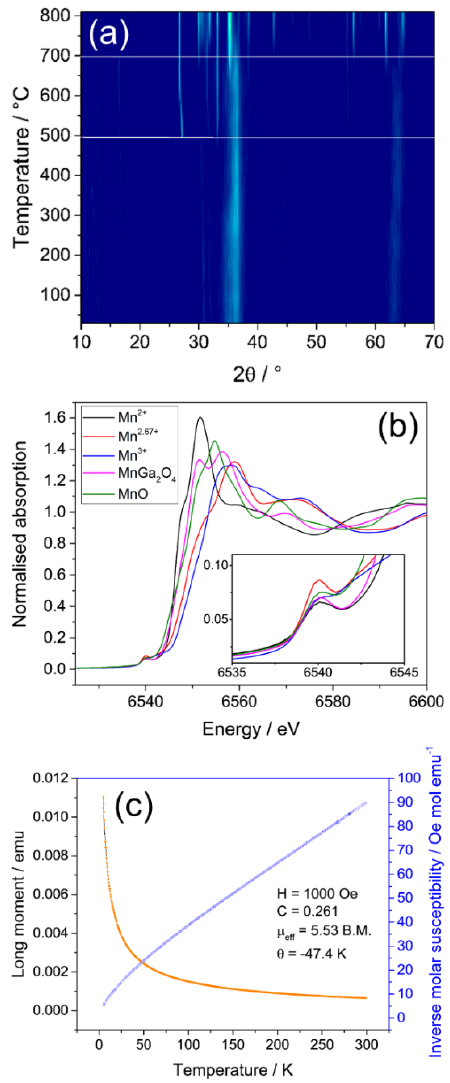
Figure 4. ( a ) In situ thermodiffractometry of manganese gallium oxide showing phase separation at 500 °C to Mn 2 O 3 and then formation of β -Ga 2 O 3 around 750 °C, ( b ) Mn K-edge XANES spectra of manganese gallium oxide with relevant reference samples, (Mn 2+ -Mn(NO 3 ) 2 · 4H 2 O; Mn 2.67+ -Mn 3 O 4 ; Mn 3+ -Mn(acac) 3 ) and ( c ) field cooled magnetometry of a sample of manganese gallium oxide (orange) displaying simple paramagnetic behaviour and inverse molar susceptibility (blue).